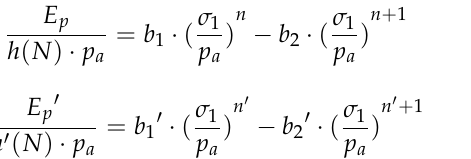
Table 3. Parameters for empirical formulations in COCT.